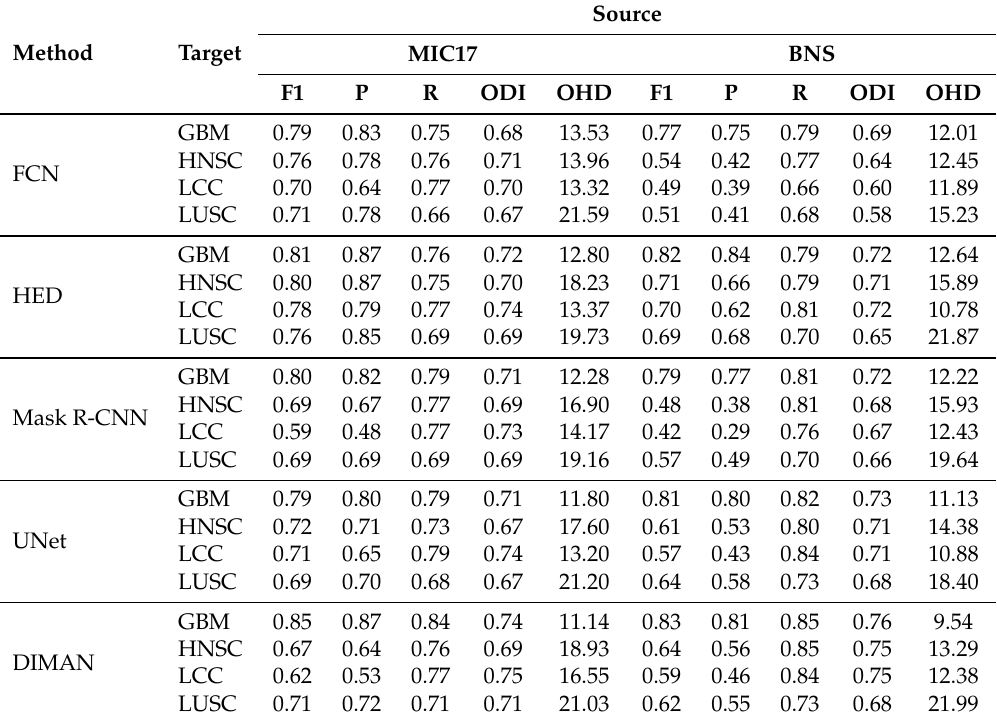
Table 2. Generalisation ability of FCN, HED, UNet, Mask R-CNN and DIMAN nuclei segmentation methods trained on MIC17 and BNS datasets and tested using the single MIC17 subsets, which were GBM, LGG, HNSC and LUSC.